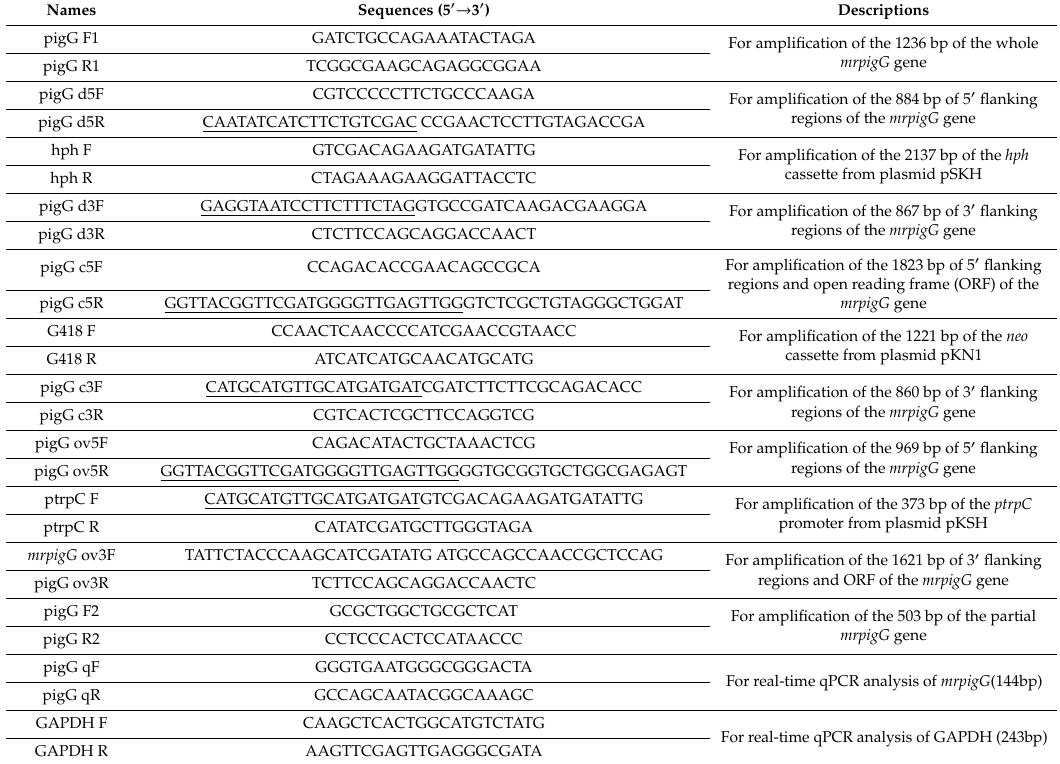
Table 2. Primers used in this